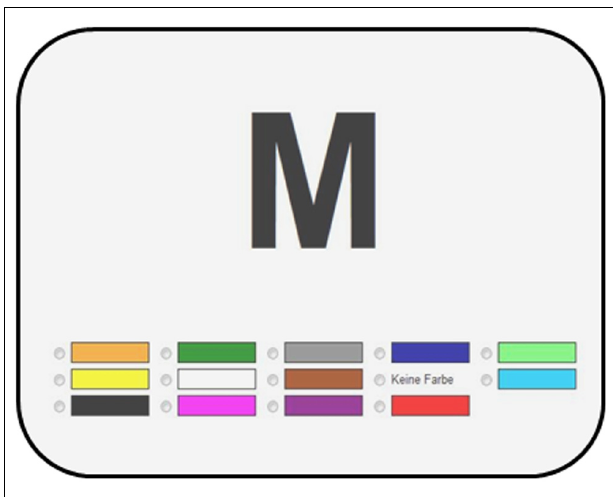
FIGURE 1 | Example trial of the consistency